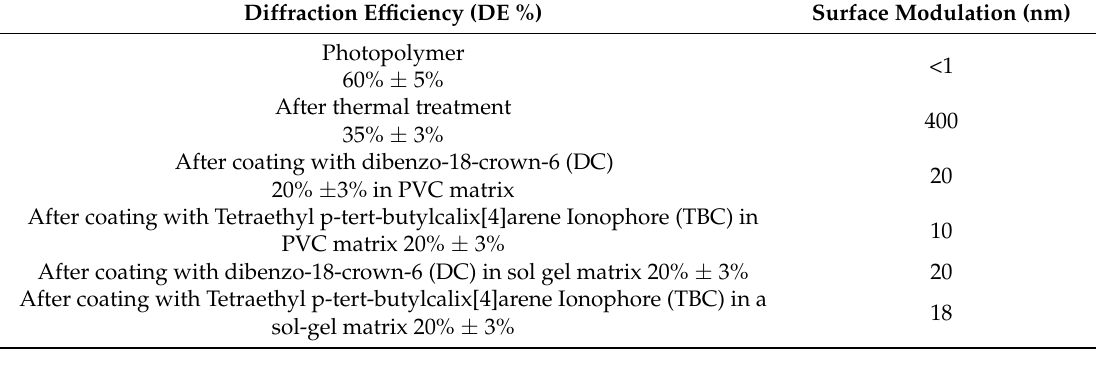
Table 3. Diffraction efficiency (DE %) and surface modulation of SRG at different stages of the experiment.